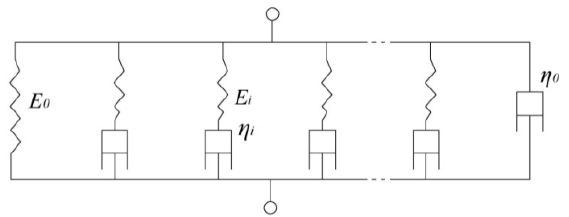
Figure 2. General Maxwell model for linear viscoelastic material.